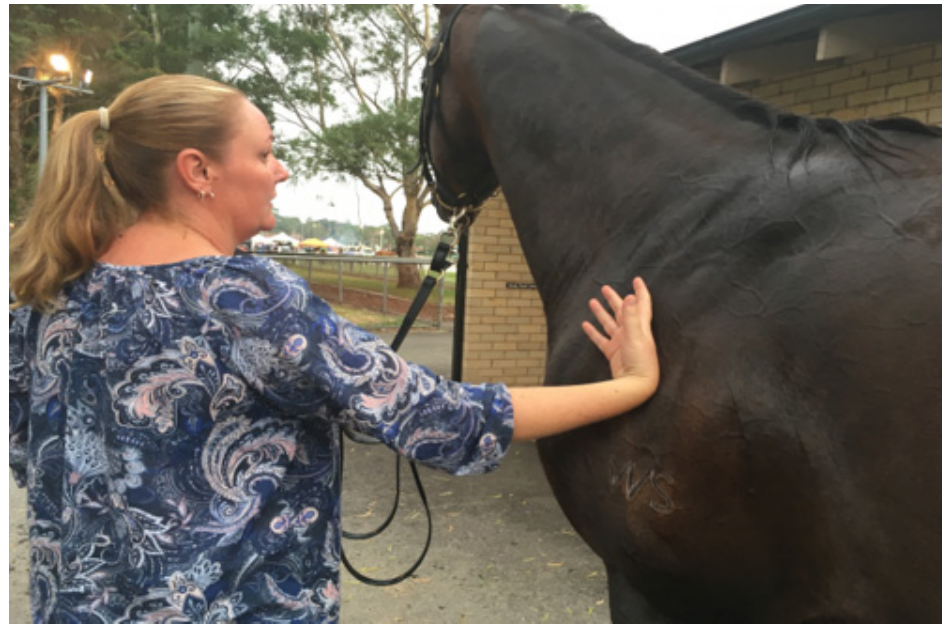
Figure 15. An experienced veterinary worker can subjectively assess skin surface temperature.